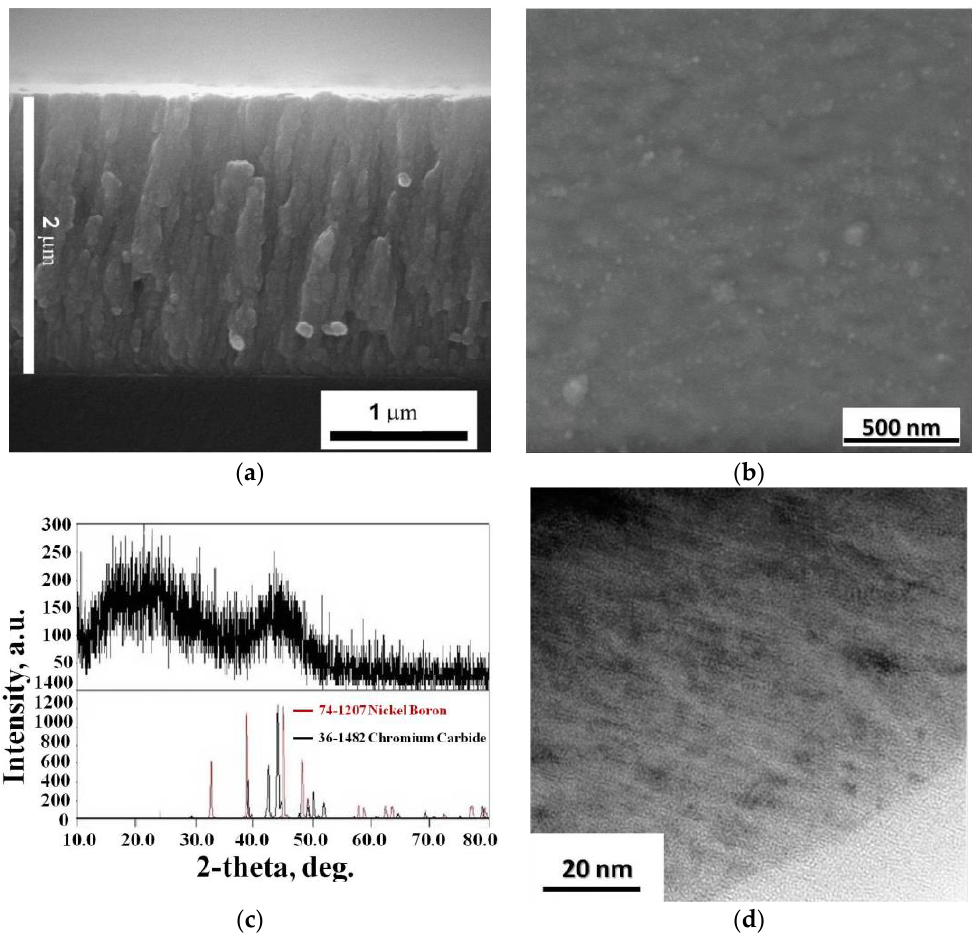
Figure 5. NiB-Cr 7 C 3 coating on the surface of a 65G steel substrate: SEM image of the fracture ( a ), and the surface ( b ), X-ray phase analysis ( с ), and TEM image ( d ).